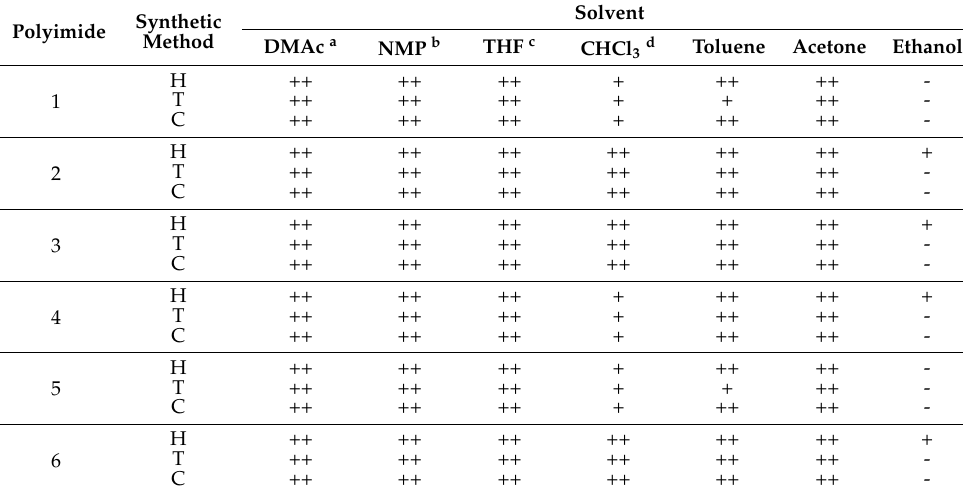
Table 4. The qualitative solubility test results of